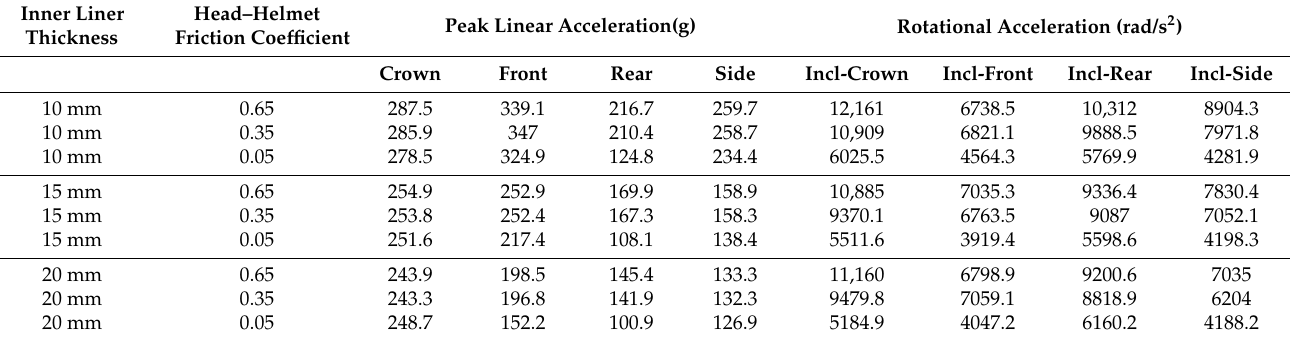
Table 4. Finite element simulation results for a ROM training data.